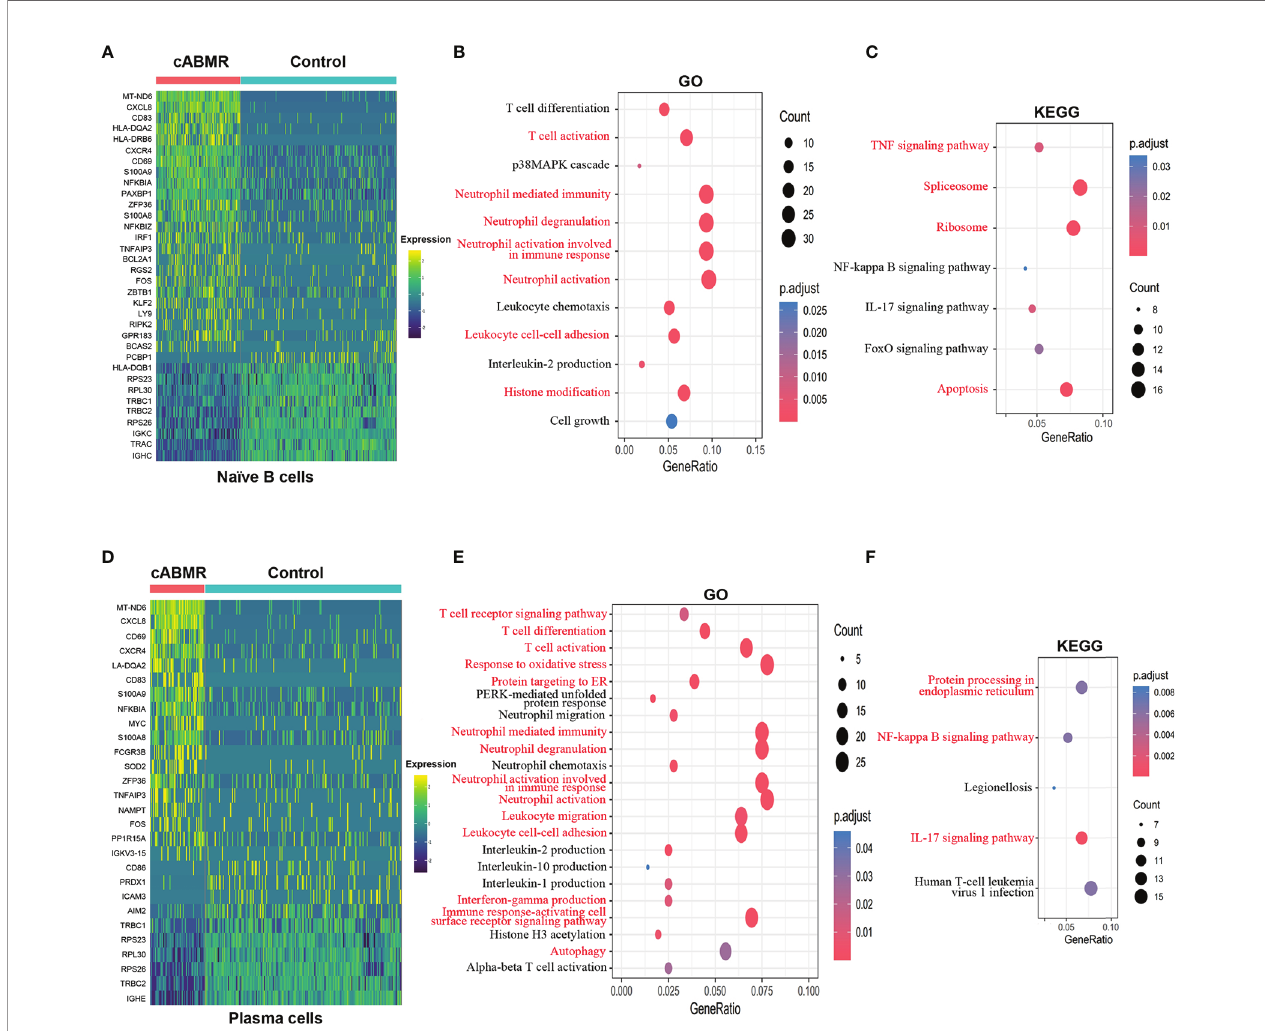
FIGURE 6 | Differential genes expression, GO and KEGG enrichment analysis in B cell subsets. (A) Heat map of differential genes expression in Naïve B cells between control and cABMR group. Each column represents a group, and each row corresponds to a marker gene for each group. Differential genes expression differential genes expression were fi ltered using a minimum log(fold change) of 0.25 and a maximum adjusted p value of 0.05 and were then ranked by average log (fold change) and FDR. (B, C) The GO (B) and KEGG (C) enrichment analysis of Naïve B cells between control and cABMR group; GO and KEGG terms are labeled with name and sorted by − log 10 (P) value. A darker red indicates a smaller P value. The node size indicates the number of genes enriched. Interesting terms are labeled in red. (D) Heat map of differential genes expression in Plasma cells between control and cABMR group; (E, F) The GO (B) and KEGG (C) enrichment analysis of plasma cells between control and cABMR group. Abbreviations were as follows: pct.exp, percentage of cells expressing gene; count, number of genes annotated to GO terms or KEGG